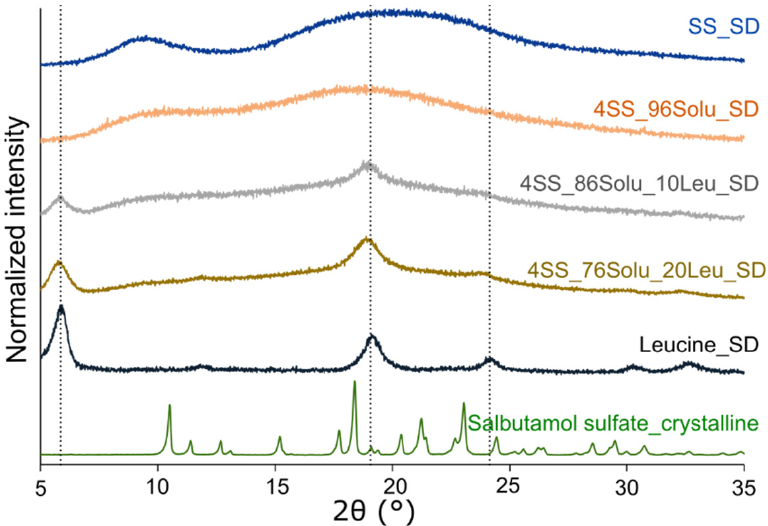
Figure 2. X-ray diffractograms of the various powders (salbutamol sulfate only (SS_SD), 4% salbutamol/96% soluplus (4SS_96Solu_SD), 4% salbutamol/86% soluplus/10% leucine (4SS_86Solu_10Leu_SD), and 4% salbutamol/76% soluplus/20% leucine (4SS_76Solu_20Leu_SD) and spray-dried leucine (Leucine_SD)).